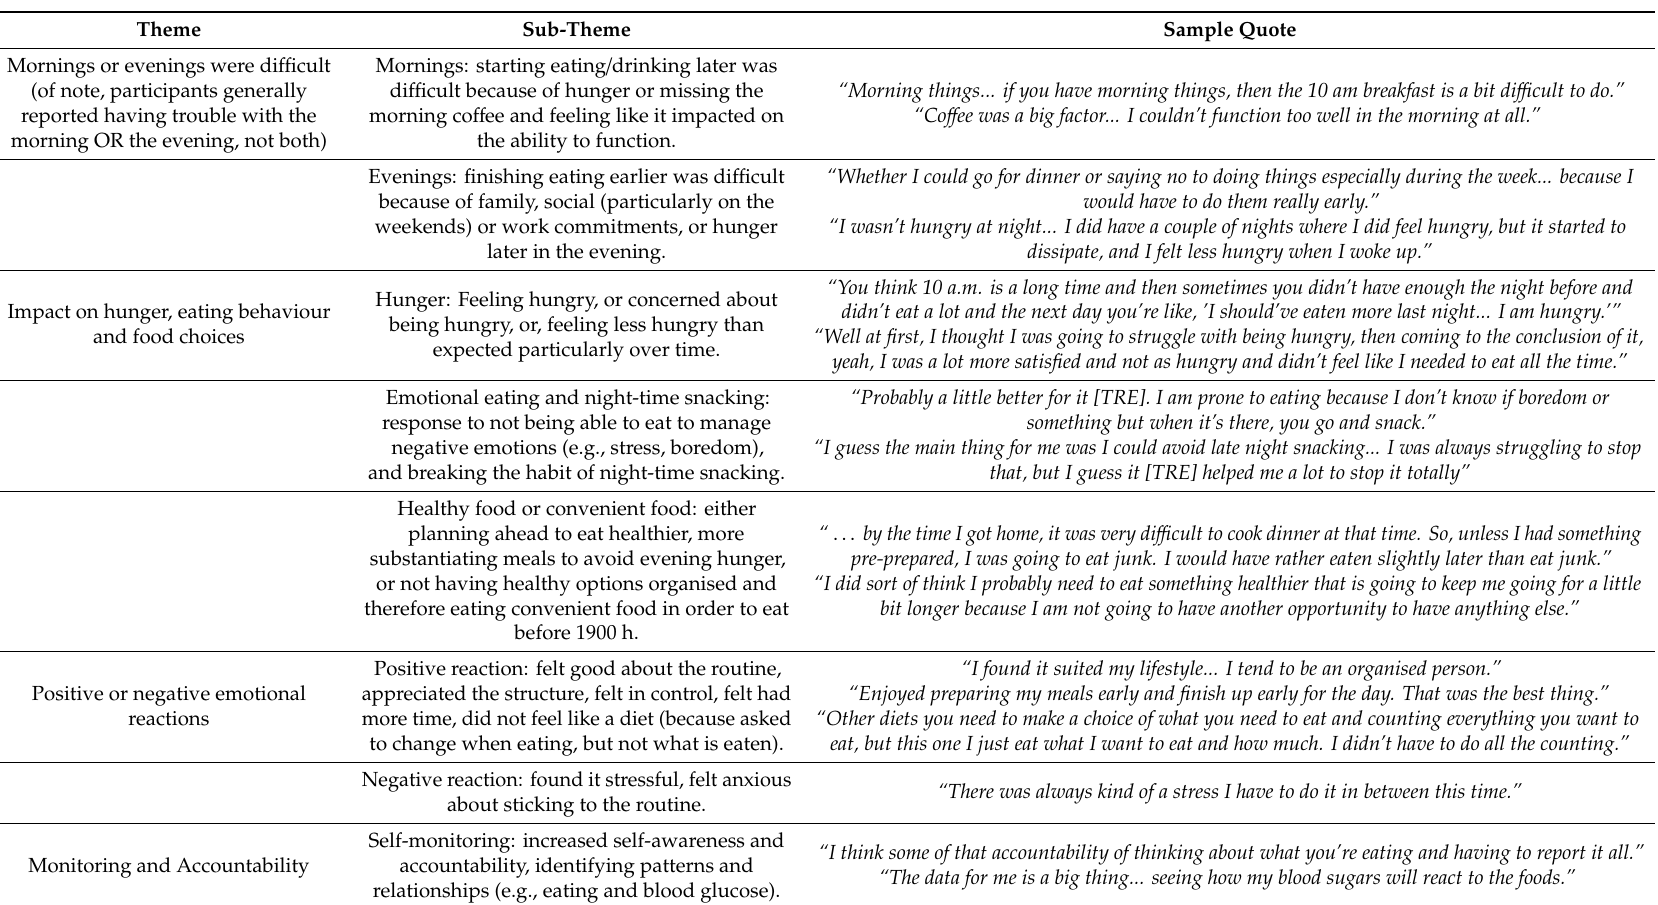
Table 8. Qualitative themes from in-person interviews ( n = 16) conducted post-TRE